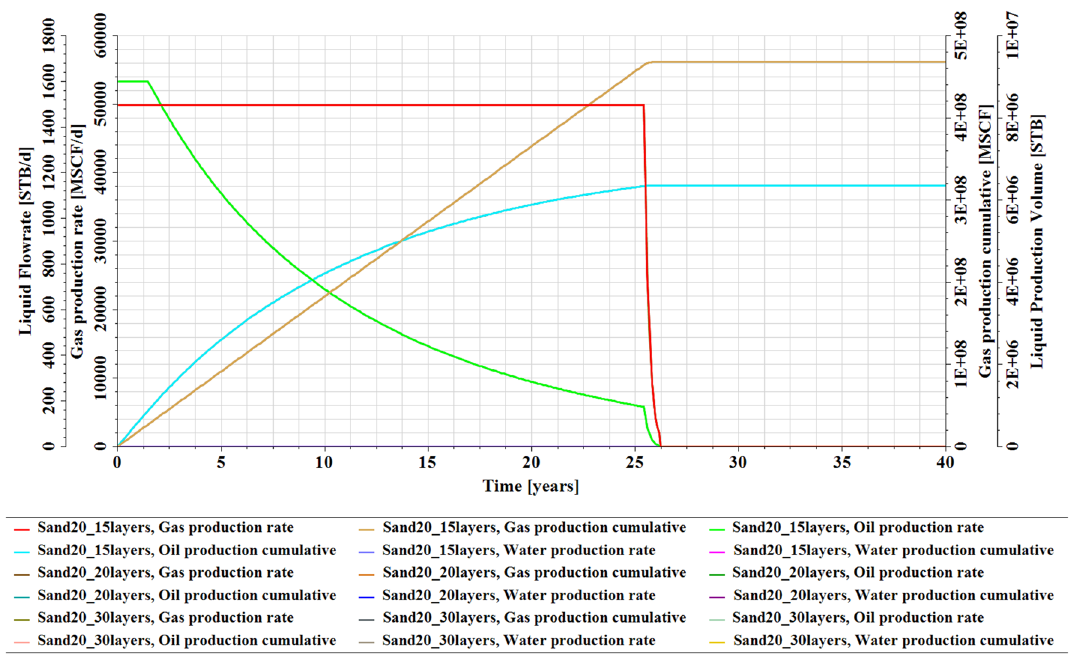
Fig. 7 Gas and oil productions for Sand20 gas condensate for three different total cells: 15, 20, and 30